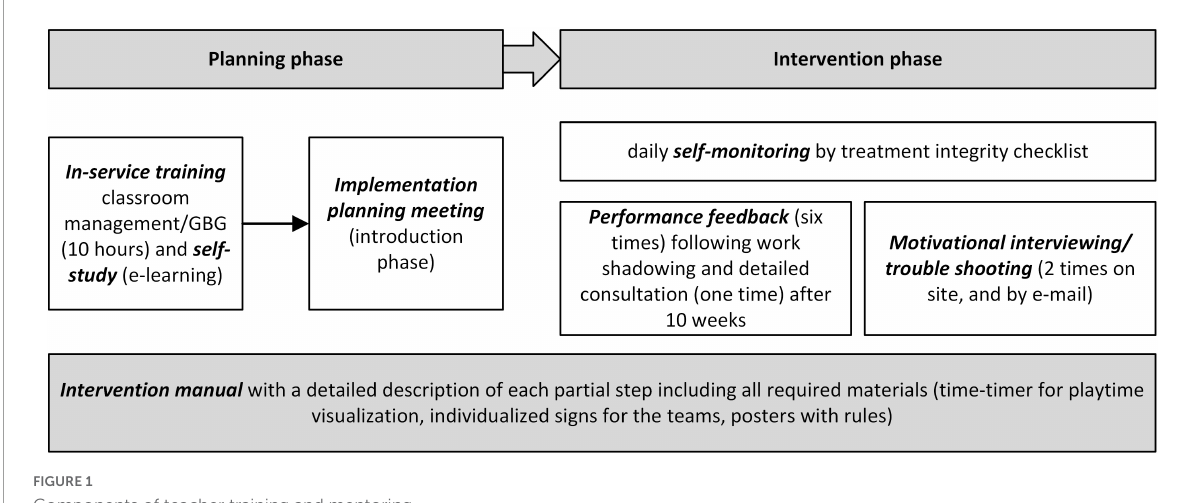
FIGURE1 Components of teacher training and